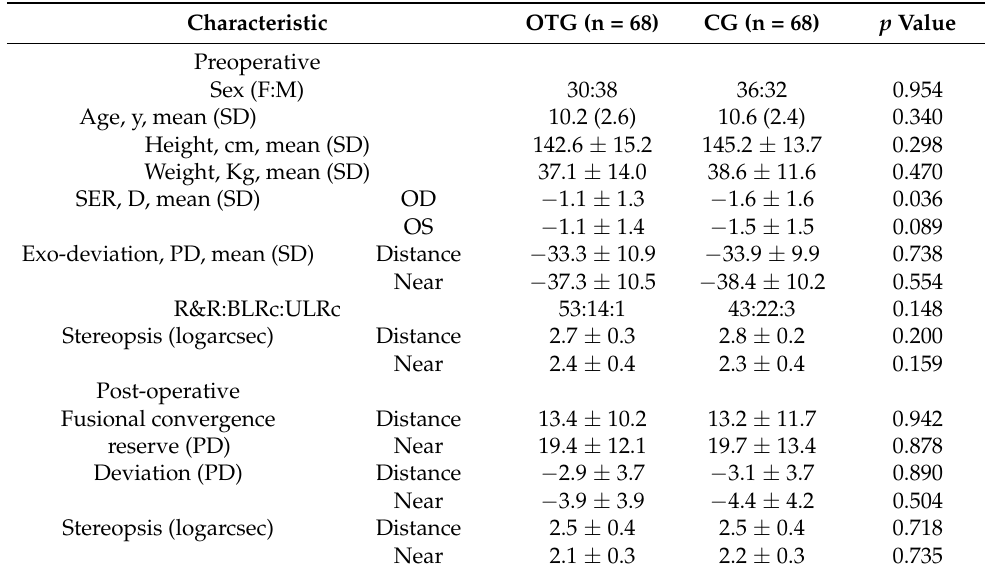
Table 1. Demographic and Baseline Clinical Characteristics of Two